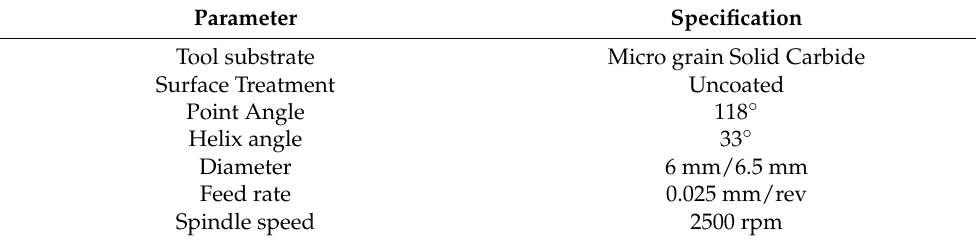
Table 5. Specification of mechanical drilling tool and drilling parameters [41,42].